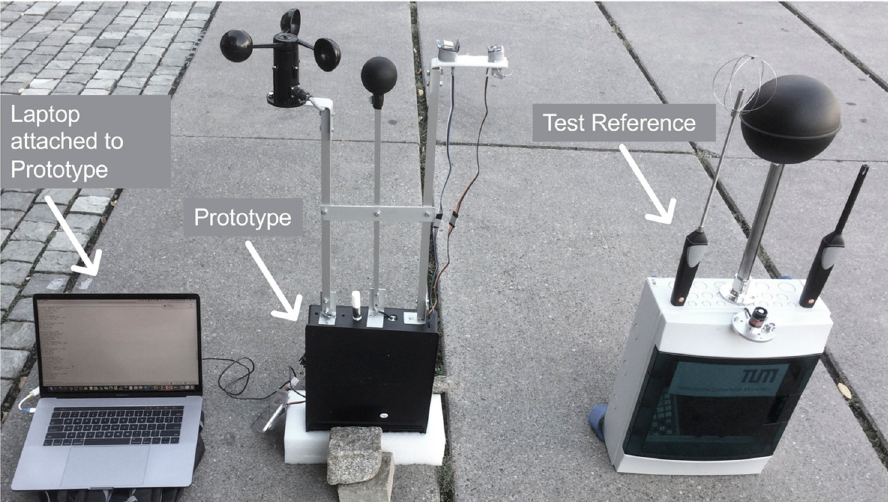
Figure 10. Validation setup with prototype and the test reference.